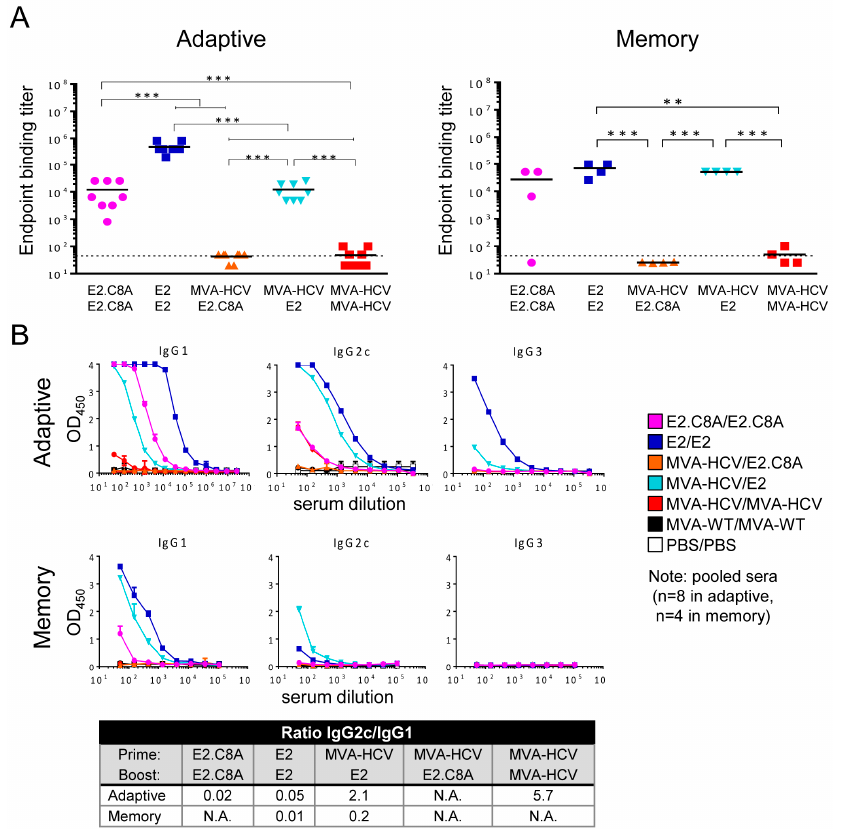
Figure 7. HCV-speci fi c humoral immune responses elicited in immunized mice. ( A ) Serum IgG Figure 7. HCV-specific humoral immune responses elicited in immunized mice. ( A ) Serum IgG binding titersagainstcommerciallyavailableH77E2protein weredeterminedbyELISA10days(left) and53days (right) post-boost in individual mice. The endpoint titer is the serum dilution at which the absorbance is three times higher than the absorbance value of the control group (MVA-WT / MVA-WT). p values indicate significant response di ff erences between immunization groups (** p < 0.005; *** p < 0.001). ( B ) Detection of IgG1, IgG2c, and IgG3 levels against H77 E2 in pooled serum from immunized mice at 10 days (upper graphs) and 53 days (lower graphs) post-boost. The table shows the IgG2c / IgG1 ratio of the di ff erent groups at adaptive and memory phases. N.A. = not